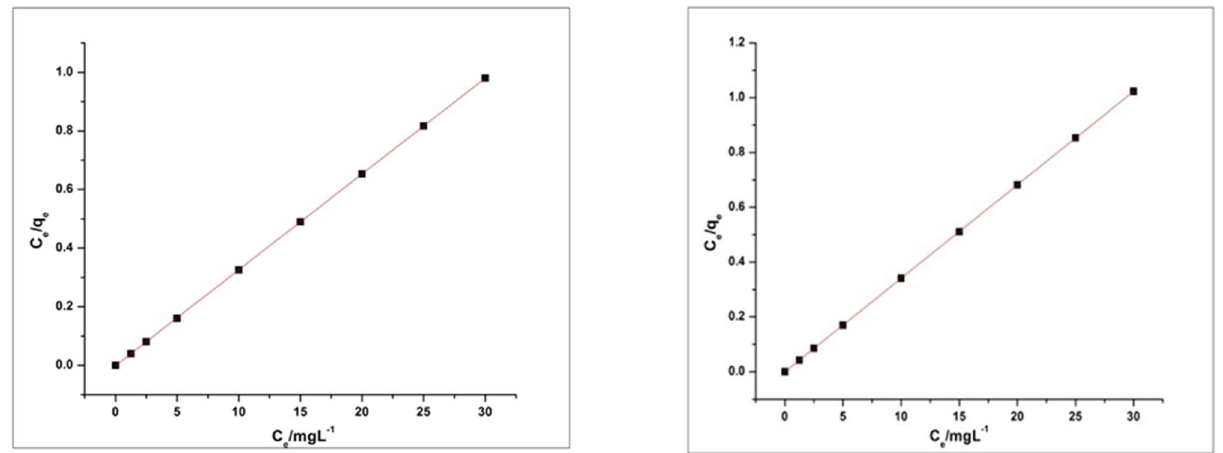
Figure 22. Langmuir adsorption isotherm of MO and RhB.